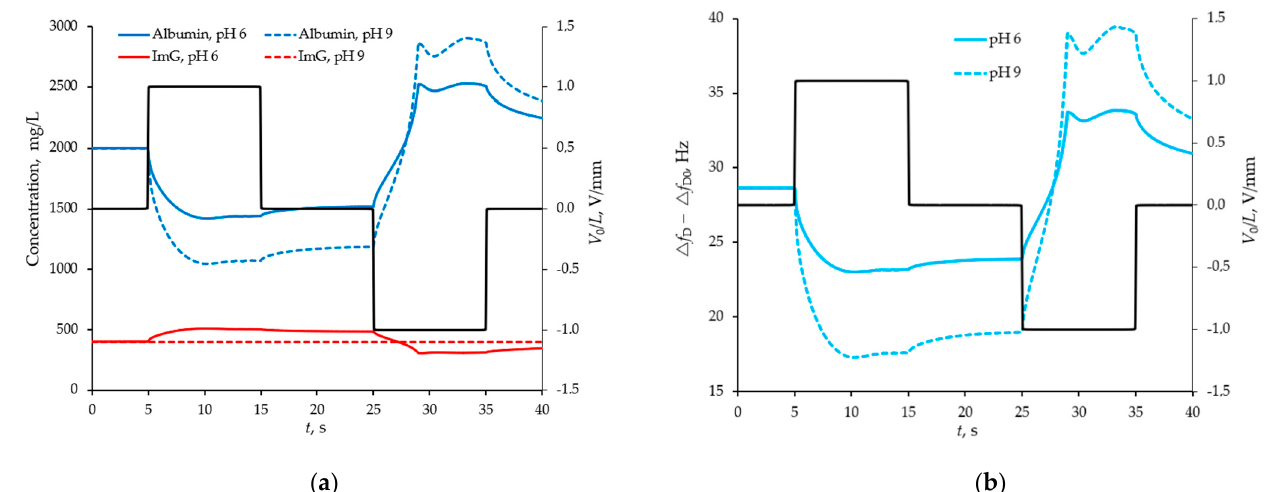
Figure 4. Average concentration of proteins (shown by red and blue curves) trapped in the space between the barriers of the sensor with the structured surface at two different pH values ( a ) and the difference response from two sensors (with smooth and structured surfaces) in the form of a shift (shown by blue curves) of their resonance frequencies ( b ) by manipulation of the model buffer solution with proteins by external pulsed field (indicated by a black broken line).